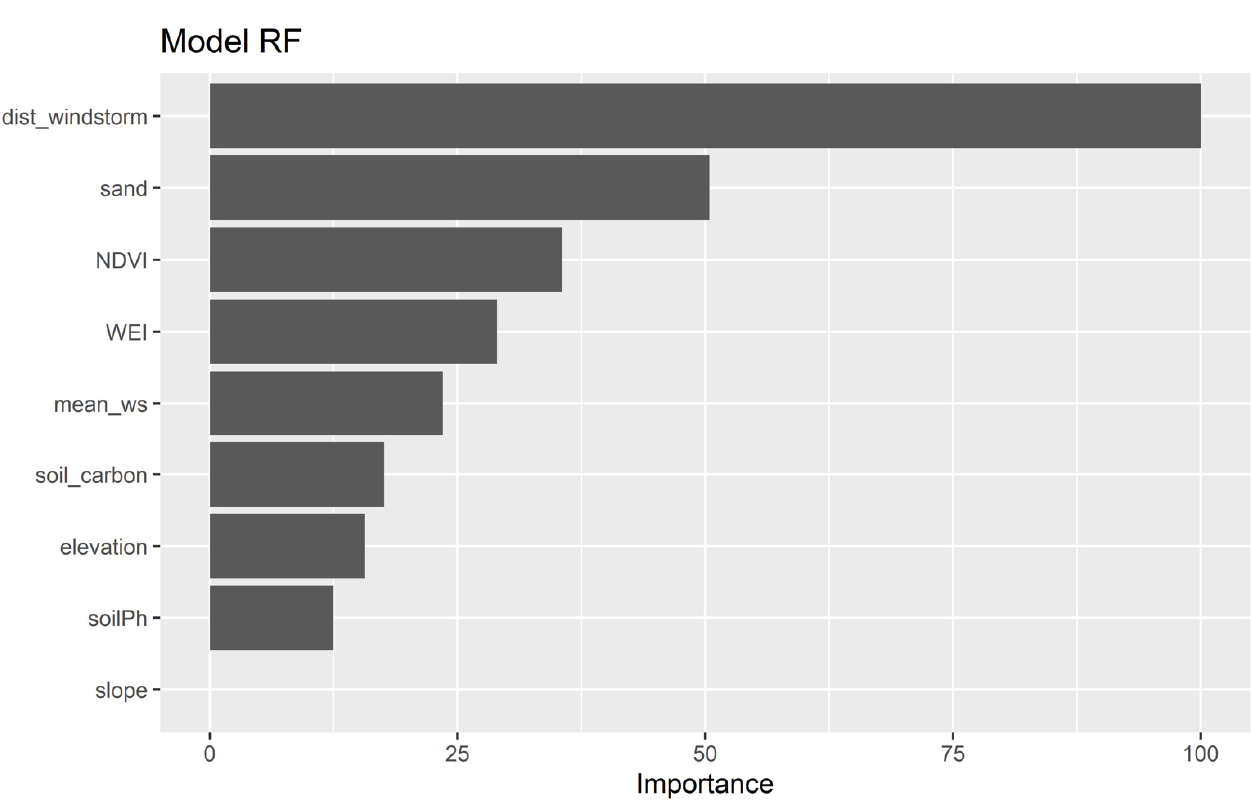
Figure 4. Feature importance plots for the best RF model. Abbreviations: dist_windstorm—distance from the windstorm Klaus trajectory, sand—sand fraction content, NDVI—Normalized Difference Vegetation Index, WEI—Wind Exposition Index, mean_ws—January mean wind speed (m s − 1 ) for 1999–2008, soil_carbon—soil organic carbon content, elevation—terrain elevation in m asl, soilPh—soil pH, slope—surface slope (in radians) (see also Table 1).